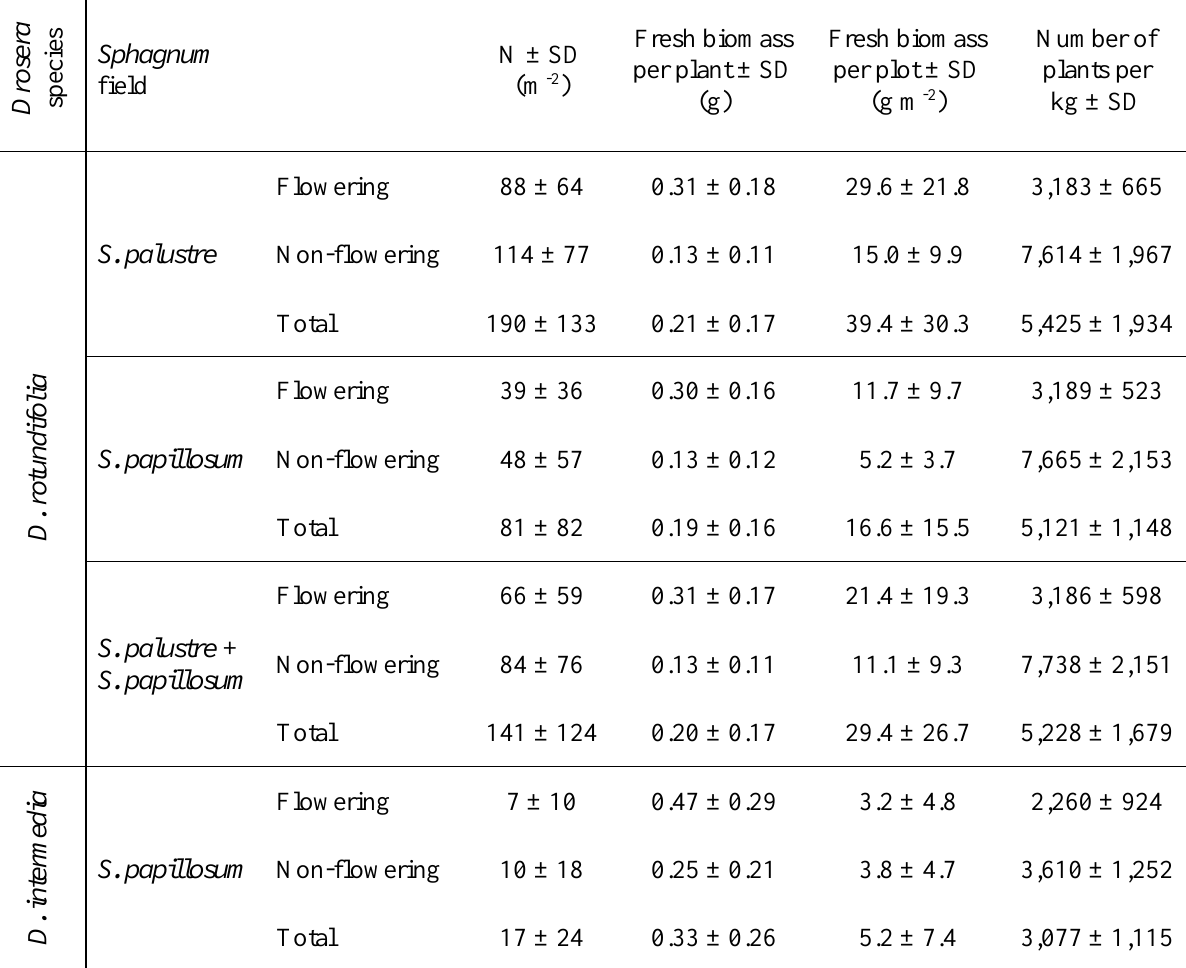
Table 3. Total biomass of Drosera rotundifolia and Drosera intermedia on Sphagnum palustre and S. papillosum fields. Flowering = plants with stalk(s); Non-flowering = plants without stalk(s); Total = flowering + non-flowering plants. Harvest dates: June–September 2013 and May–September 2014 ( n = 23 per Sphagnum species; 2013: 2 plots × 4 months; 2014: 3 plots × 5 months). N = plant density (number of plants per square metre). No flowering plants were found in May 2014.